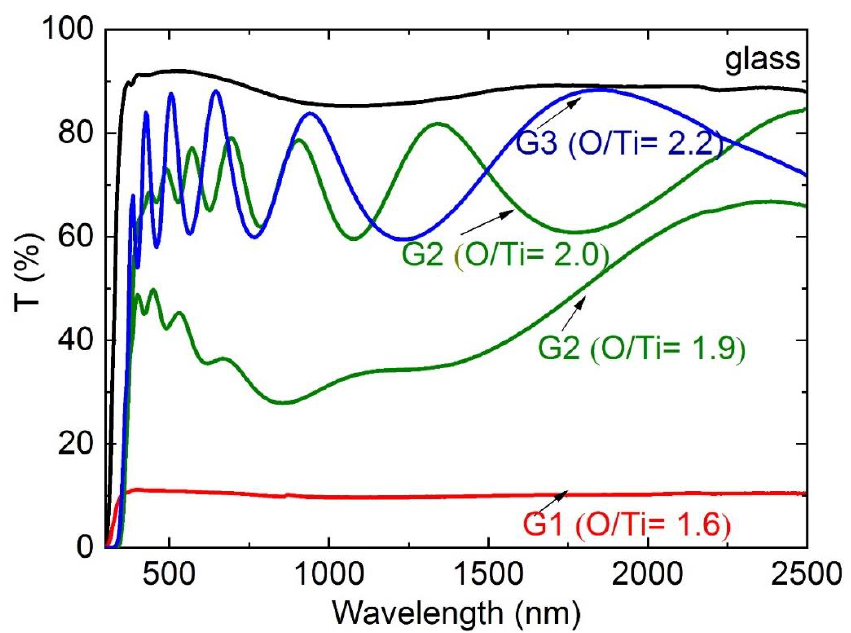
Figure 9. Transmittance of selected representative samples deposited on glass. The reference was air and the spectrum of glass substrate is also included in the graph. The code color indicates the samples belonging to group 1 (red), 2 (green), and 3 (blue), and the O/Ti ratio of the different samples is indicated next to each line.